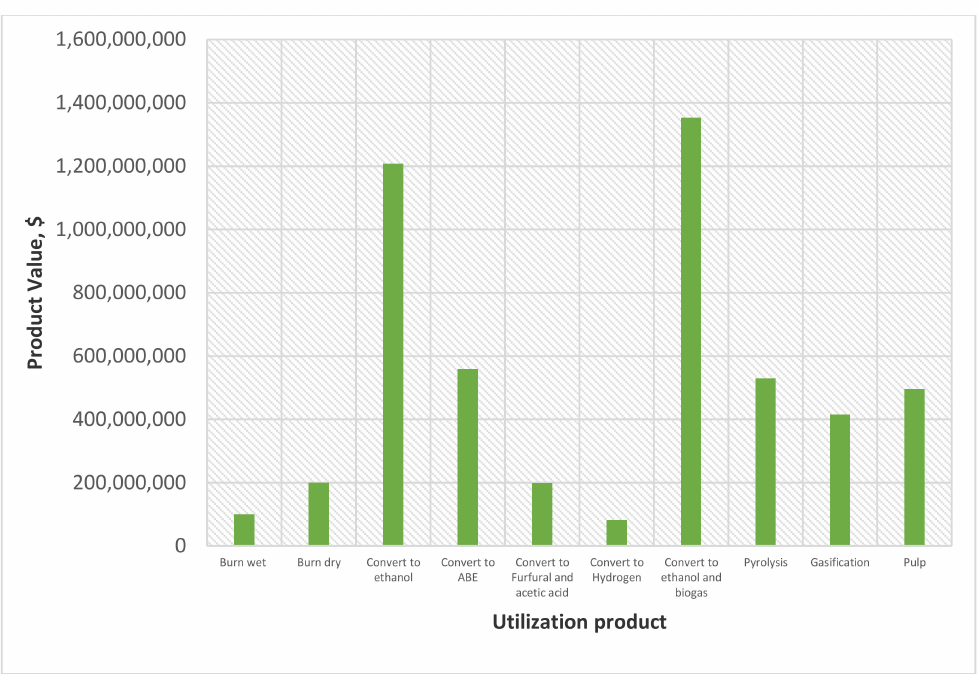
Figure 4. Potential revenue from different utilisation processes of bagasse, the leftover solid was not considered in the calculation.